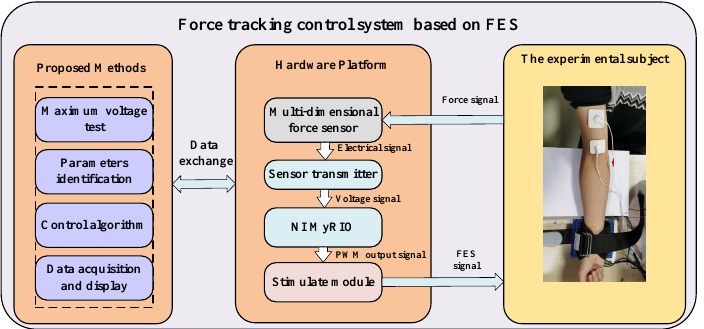
Figure 1. Structure diagram of force tracking control